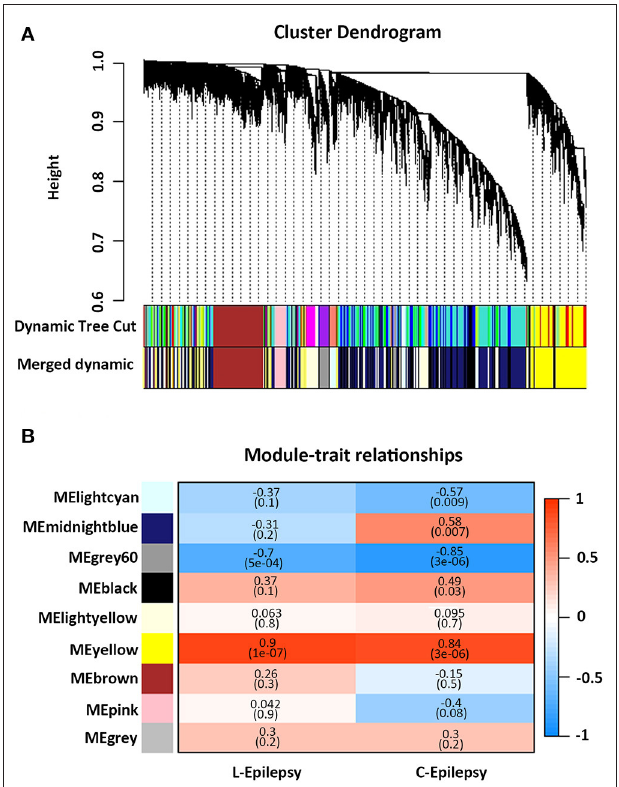
FIGURE 1 | Weighted gene co-expression network analysis. (A) Cluster dendrogram of genes based on module eigengenes. The colored bars below cluster dendrogram correspond to different modules. (B) Correlation between module eigengene (ME) expression value and epilepsy (sham- − 0, epilepsy in latent periods- − 1), (sham- − 0, epilepsy in chronic periods- − 1) for each module. Pearson correlation is reported with the P value given inside the bracket.